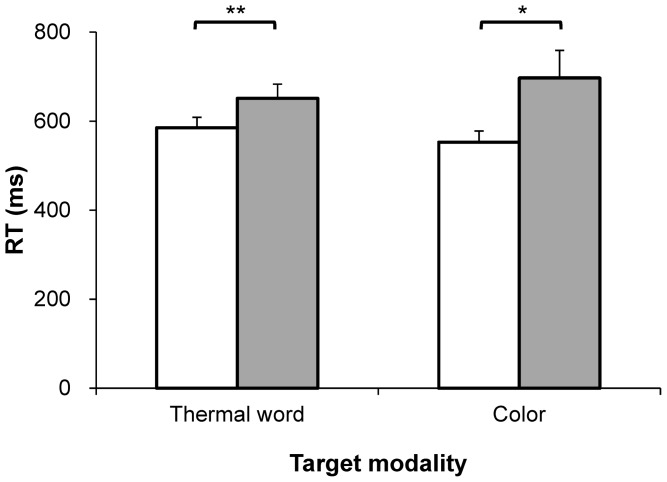
Results of the IAT task.RTs when participants discriminated the thermal words or colours in the IAT task (Experiment 1). Congruent key assignments are shown in white, incongruent assignments in gray. The error bars show the standard errors of the means. * and ** indicate statistical significance of p<.05 and p<.01, respectively (paired two-tailed t test).